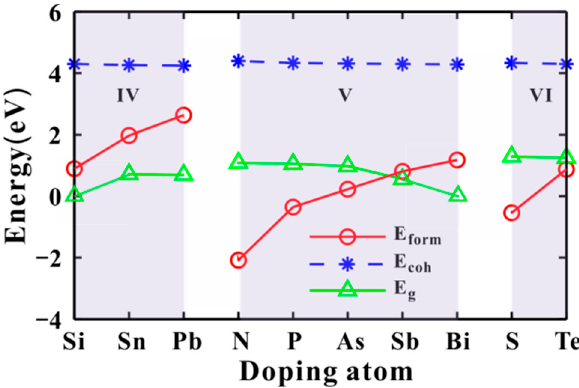
Figure 3. Formation energy ( E form ), cohesive energy ( E coh ) and bandgap ( E g ) while doping different group IV–VI atoms into GeSe monolayers.